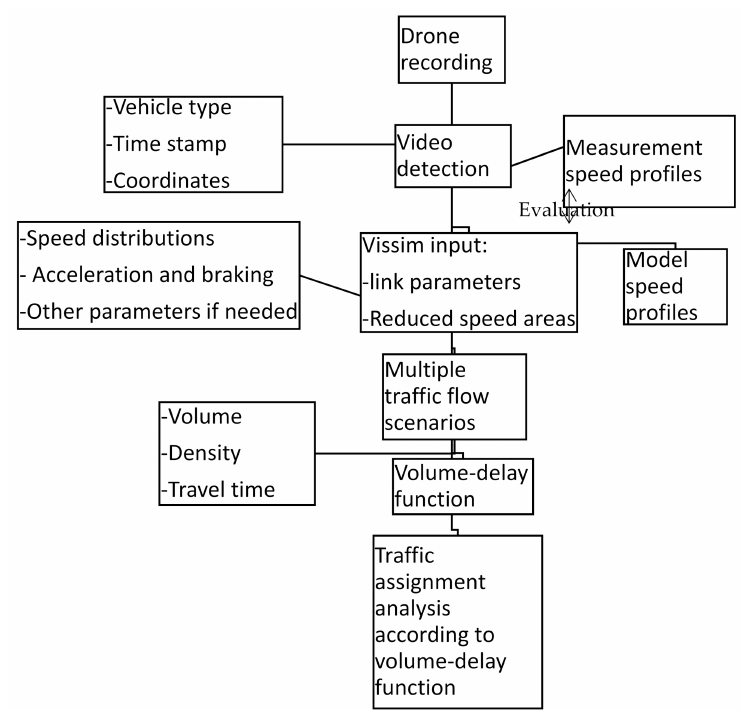
Figure 5. Methodology diagram. Source: